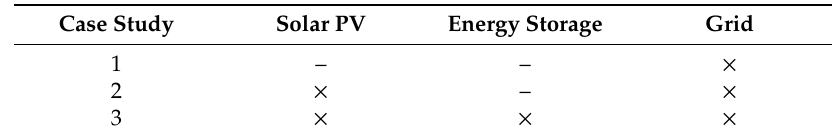
Table 1. Summary of case studies: Participation of solar photovoltaic (PV) panels, energy storage systems, and the electric grid